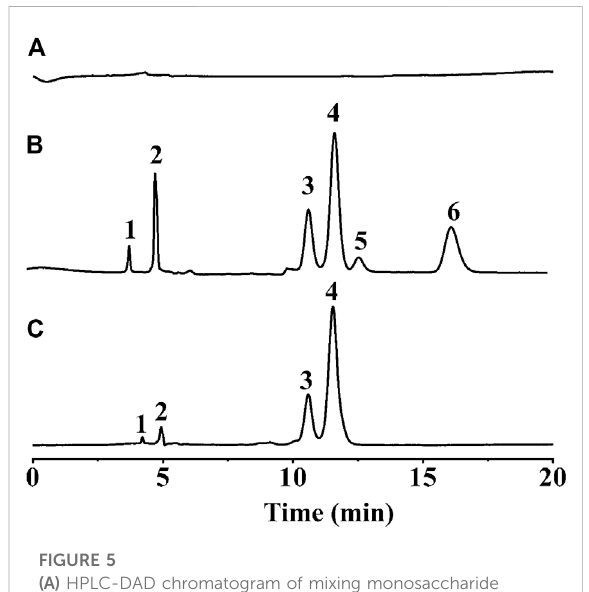
FIGURE 5 (A) HPLC-DAD chromatogram of mixing monosaccharide standard samples; (B) HPLC-DAD chromatogram of mixing HAN- monosaccharide standard samples; (C) HPLC-DAD chromatogram of PSP after derivatization; (Peak 1, HAN- GlcA, t R = 4.03 min; Peak 2, HAN-GalA, t R = 4.92 min; Peak 3, HAN-Gal, t R = 10.77 min; Peak 4, HAN-Glc, t R = 11.71 min; Peak 5, HAN-Man, t R = 12.76 min; Peak 6, HAN-Rha, t R = 16.31 min).